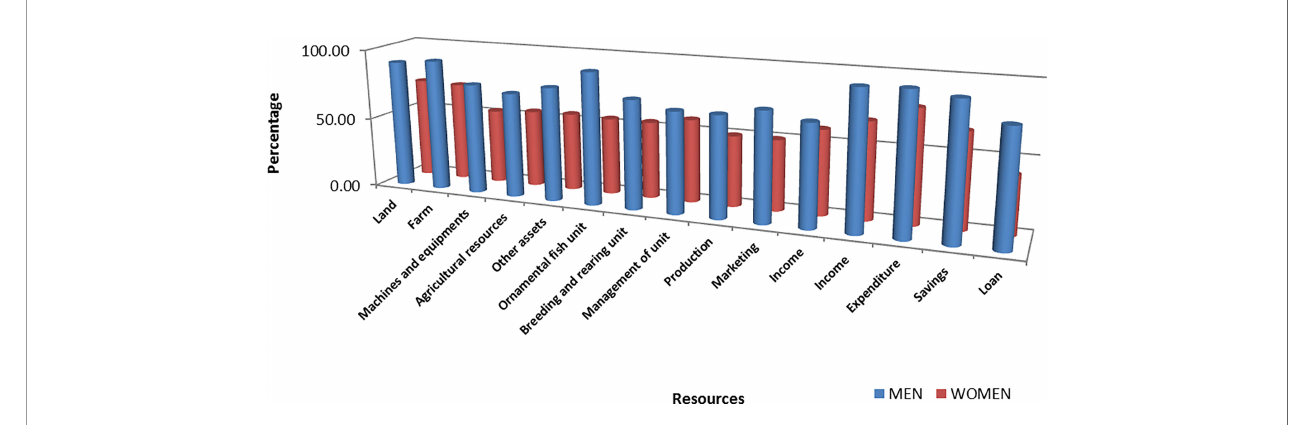
FIGURE 6 | Control over household, fi sheries, and fi nancial resources by men and women.